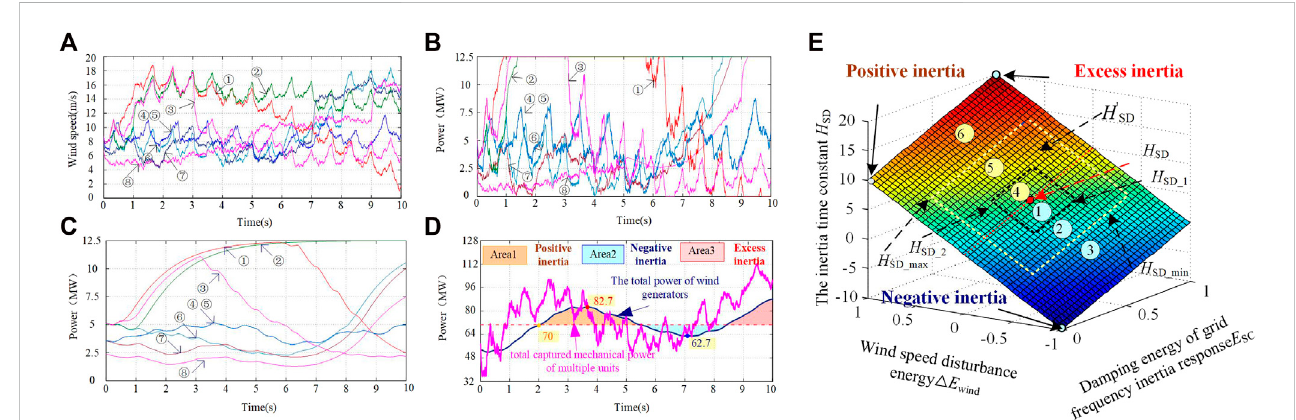
FIGURE 5 Thecurvesofcapturedmechanicalpower andgenerated powerofsingle machine andwindfarmunderdifferentwind speedsandthein fl uence ofwind speed variation on inertia